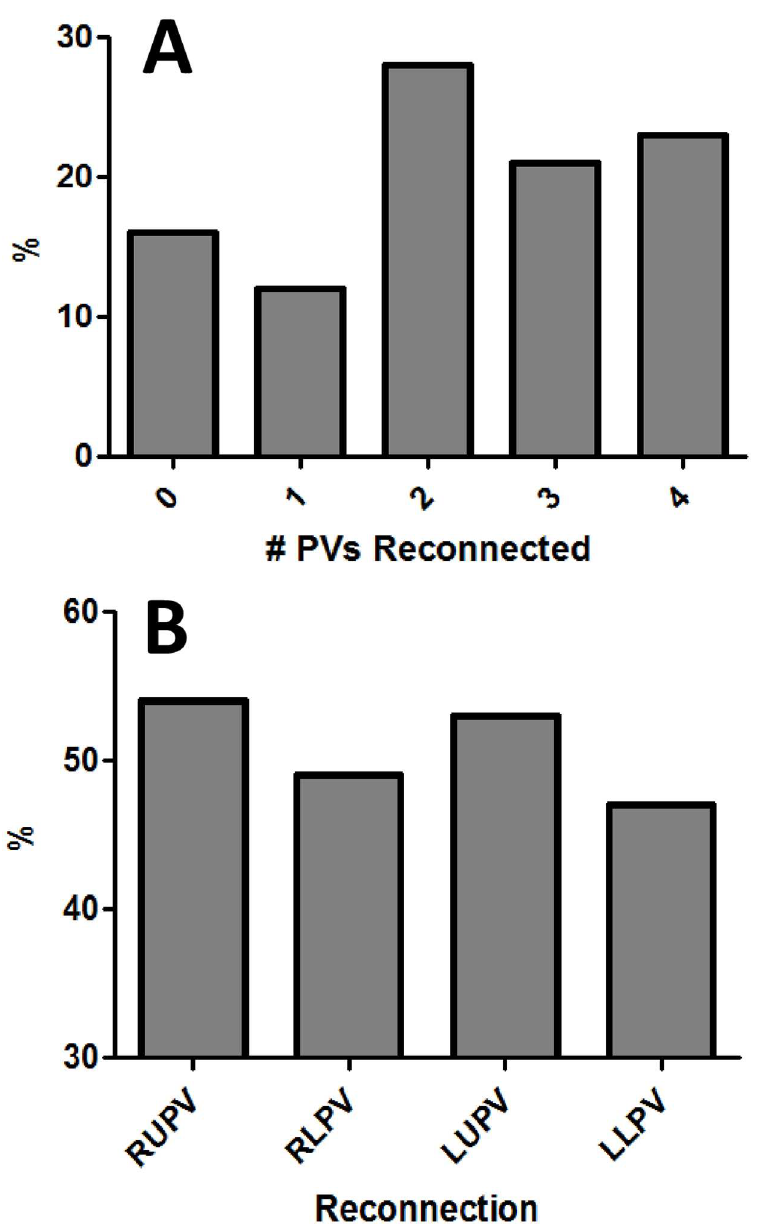
Fig 1. Panel A displaysthe proportionof subjectsaccordingto the number of PVs found to be reconnected at the time of repeat AF ablation. Panel B displaysthe proportionof PV reconnection per specific PV (RUPV = right upper PV, RLPV = right lower PV, LUPV = left upper PV, LLPV = left lower